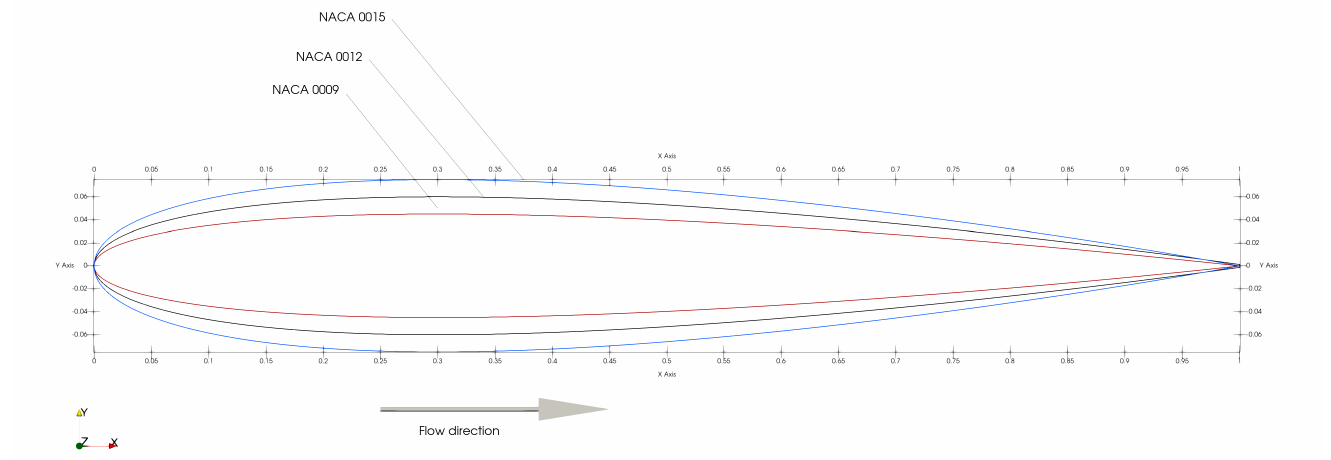
Figure 1. Comparison of the three airfoil geometries for a cord c = 1 m. Maximum thickness ratios t / c range from 0.09 to